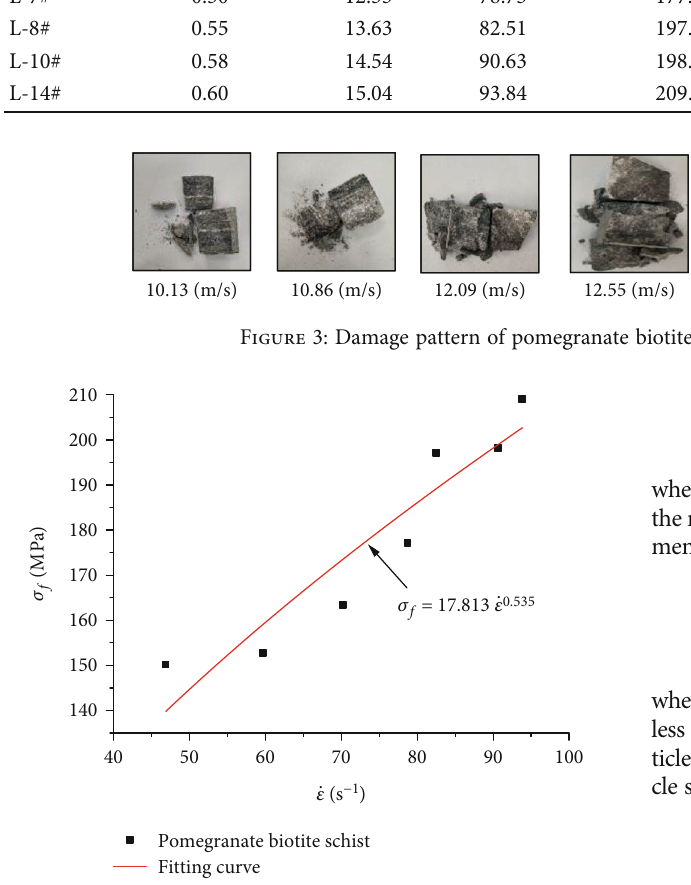
Figure 4: Dynamic compressive strength versus strain rate for pomegranate biotite schist.